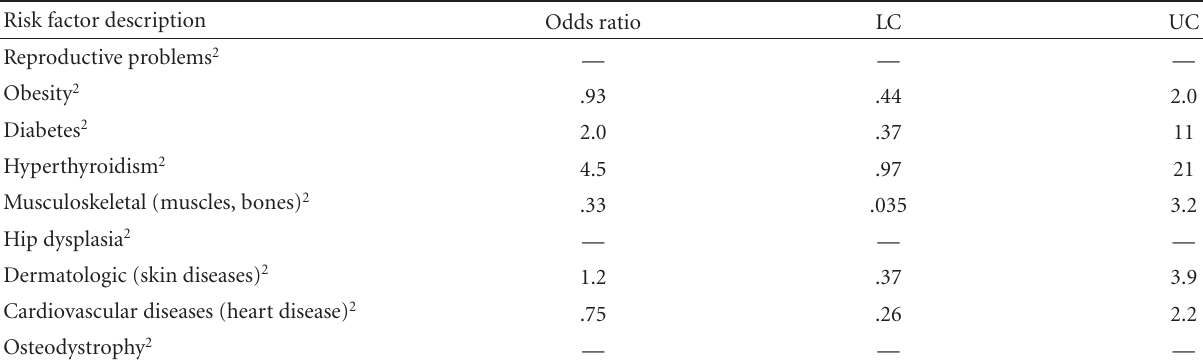
Observations in all years before the CKD diagnosis in the case.